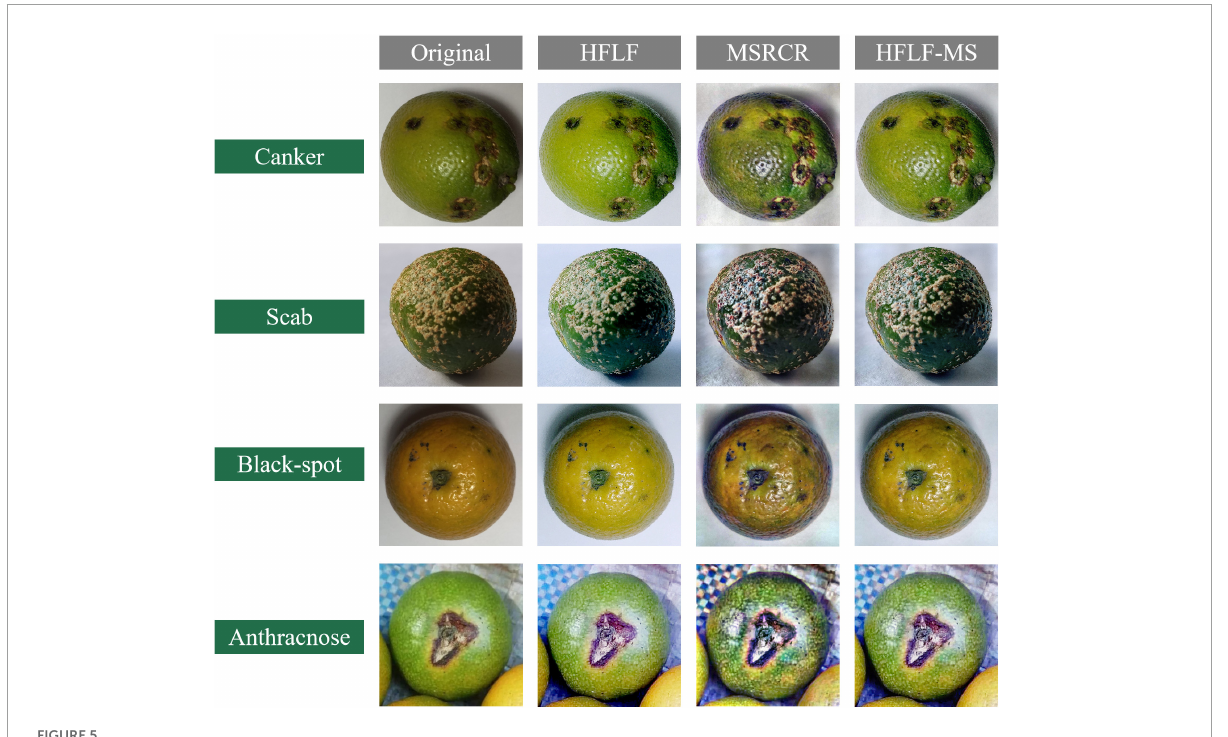
FIGURE5 Enhancement of citrus disease